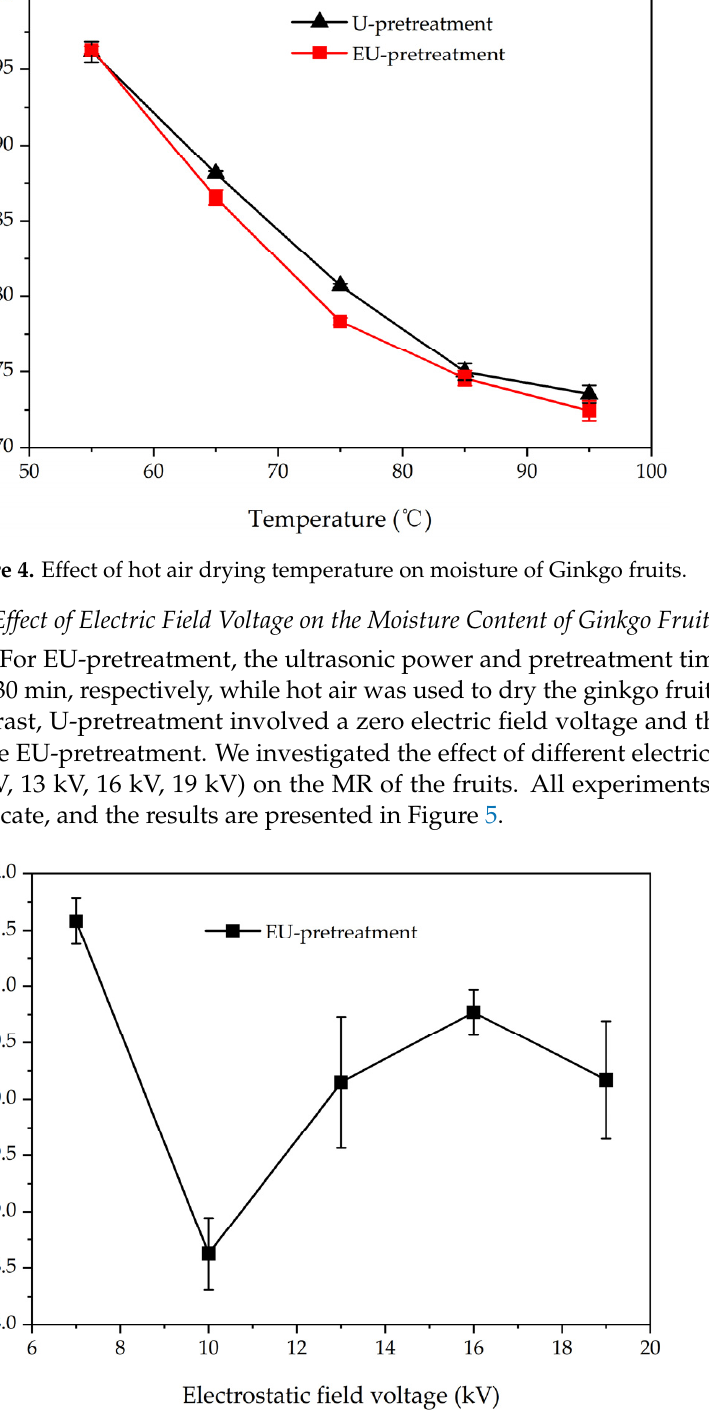
Figure 4. Effect of hot air drying temperature on moisture of Ginkgo fruits.